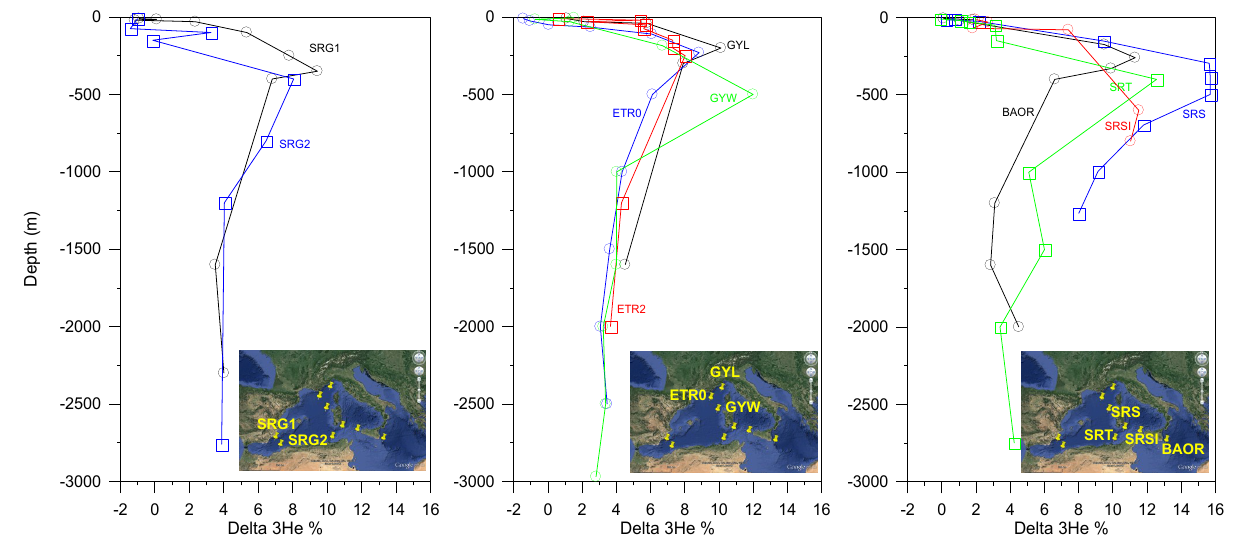
Fig. 10. δ 3 He profiles (%) of Phycemed 1983, left: western stations, centre: northern stations, right: southeastern stations. For station positions see inset